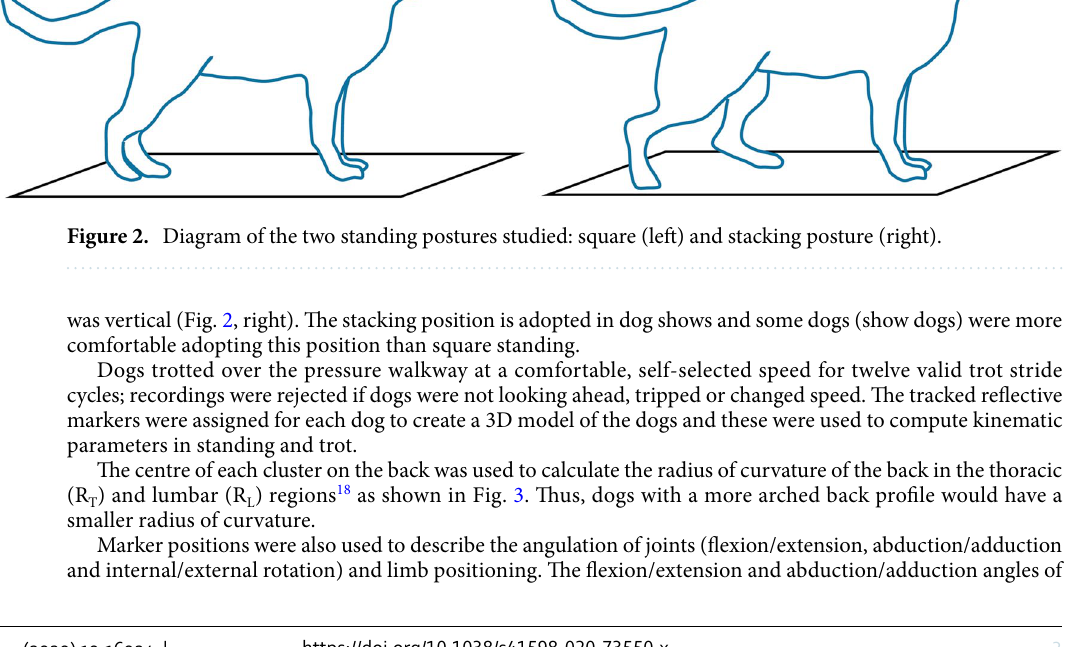
Figure 2. Diagram of the two standing postures studied: square (left) and stacking posture